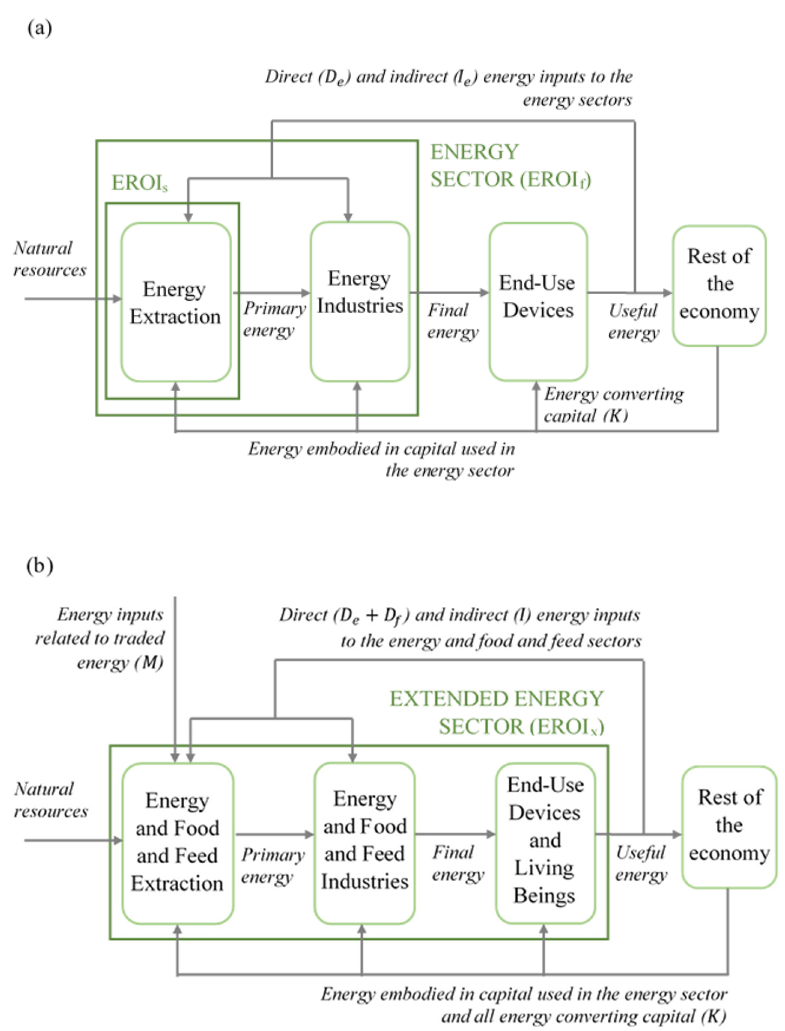
Figure 2. Scheme of the boundaries, flows, and transformation sectors considered for different EROI calculations. ( a ) EROI s : standard, primary stage; EROI f : final stage; ( b ) EROI x : comprehensive measure introduced by this study, useful stage. Authors’ own scheme.